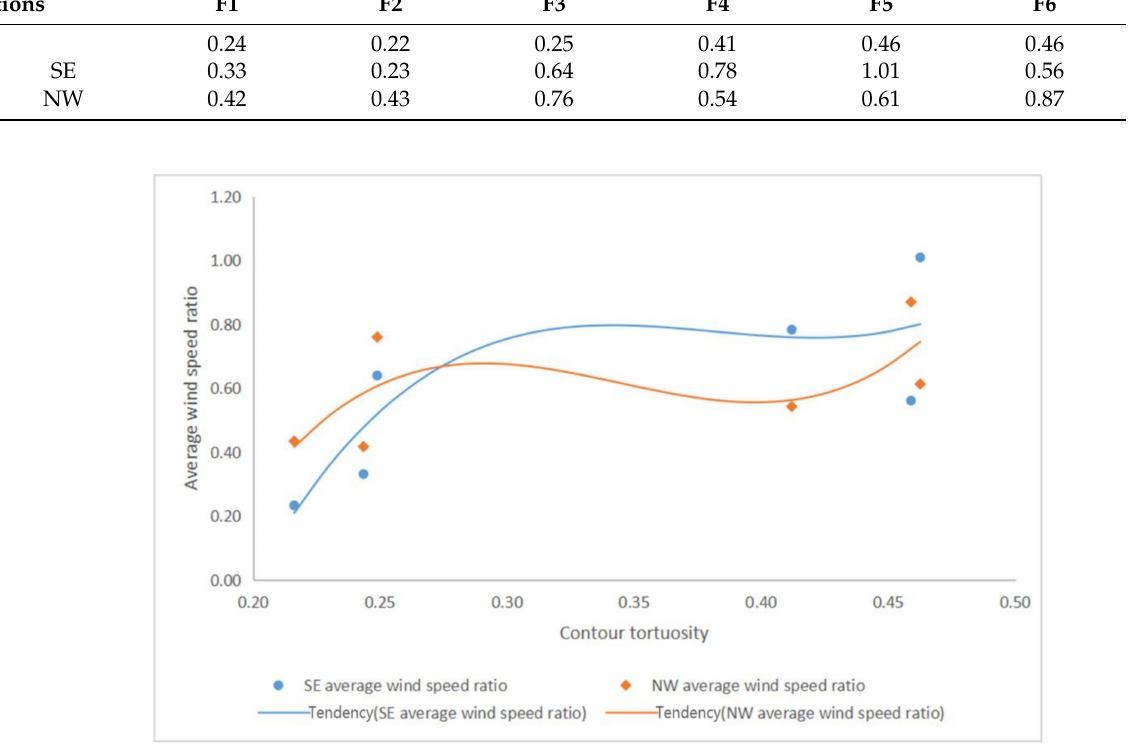
Figure 19. The relationship between the average wind speed ratio and contour